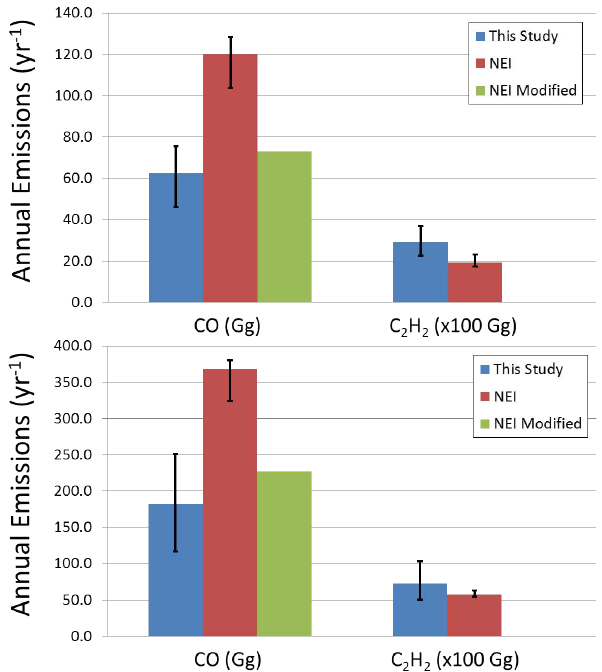
Fig. 7. Emissions estimates of CO and C 2 H 2 from Weld/Larimer counties (top) and the Denver metro counties (bottom). Top-down emissions, calculated using Eq. (4), are shown as blue bars, with uncertainties given as described in Sect. 3.3. Bottom-up emissions estimates from the NEI (2005 for C 2 H 2 and 2008 for CO) inven- tory (red) are included for comparison for each species, as well as a modified bottom-up CO inventory as described in the text. Note the differences in units for the two trace